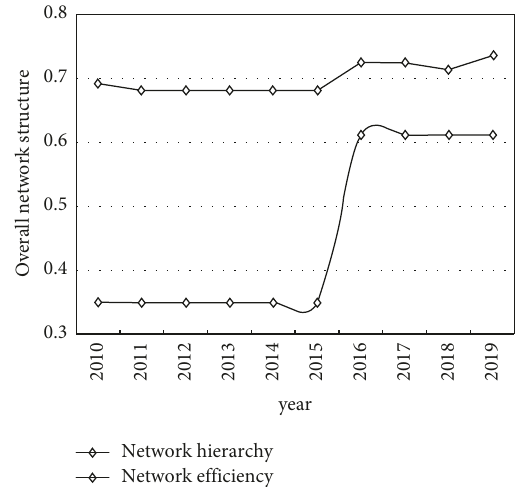
Figure 3: Evolution of network level and